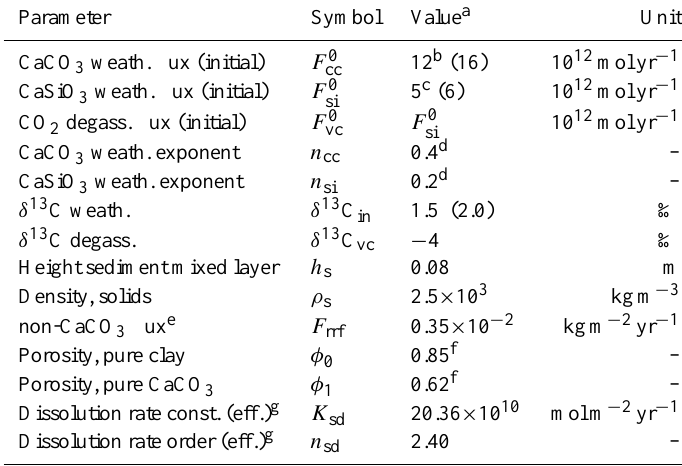
Table 3. Weathering and sediment model parameters. Parameter